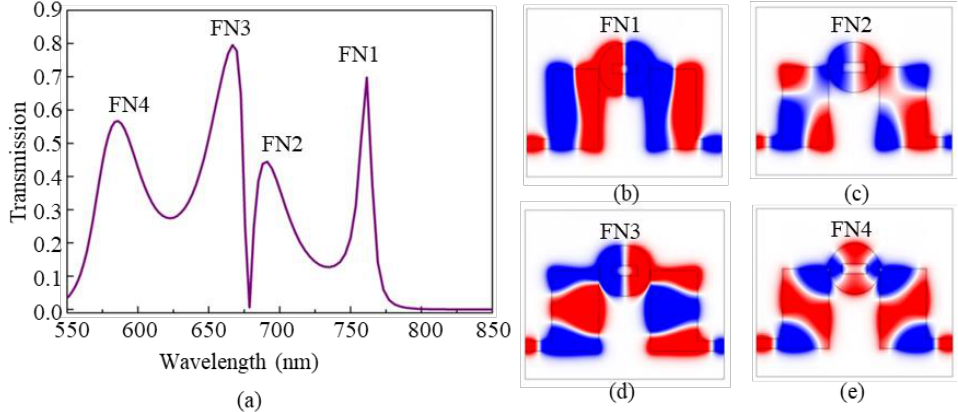
Figure 2. ( a ) The transmission of the coupled-waveguide-cavity structure, and the H z magnetic-field distributions at the Fano peaks of ( b ) FN1 with λ = 761 nm, ( c ) FN2 with λ = 690 nm, ( d ) FN3 with λ = 668 nm, and ( e ) FN4 with λ = 585 nm.